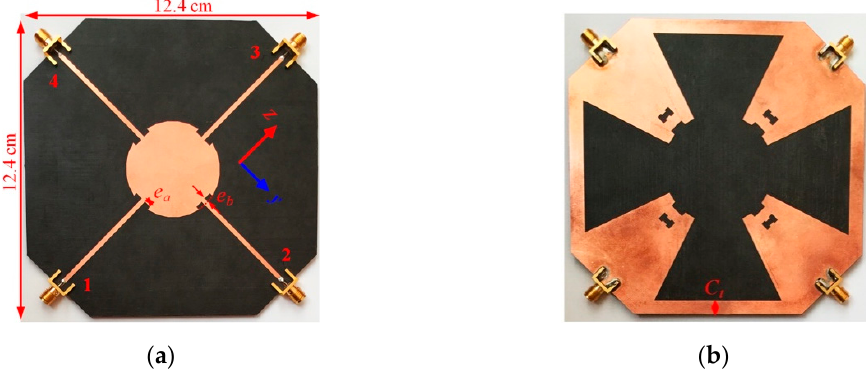
Figure 11. Fabricated four-port antenna: ( a ) top view; and ( b ) bottom view.